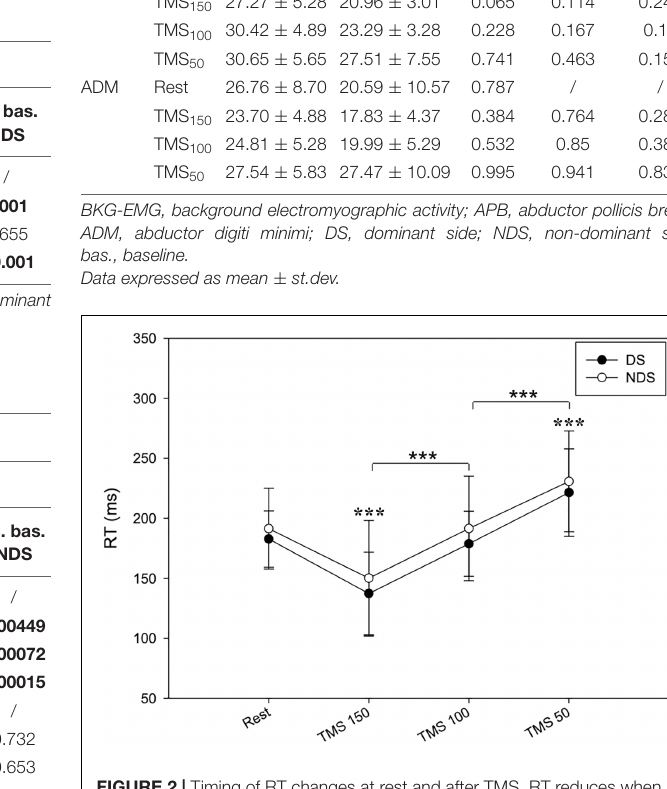
FIGURE 2 | Timing of RT changes at rest and after TMS. RT reduces when TMS was delivered at 150 ms and progressively increases when TMS was delivered at 100 and 50 ms before the EMG onset. No significant changes were detected between the two sides. Data expressed as mean ± standard deviation (rmANOVA *** p <